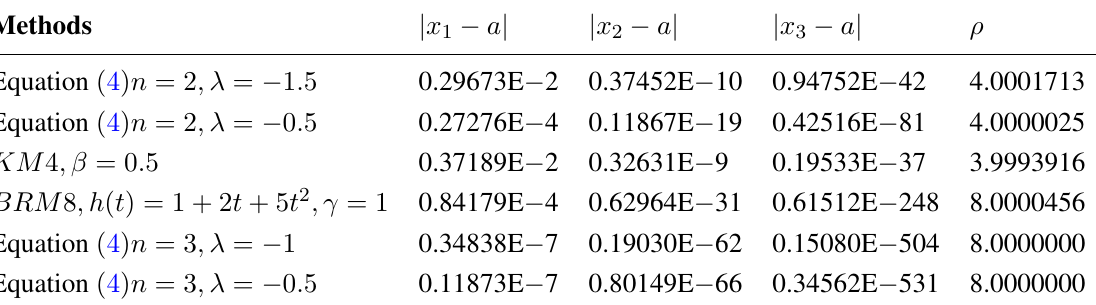
( x ) by the methods without memory. 2